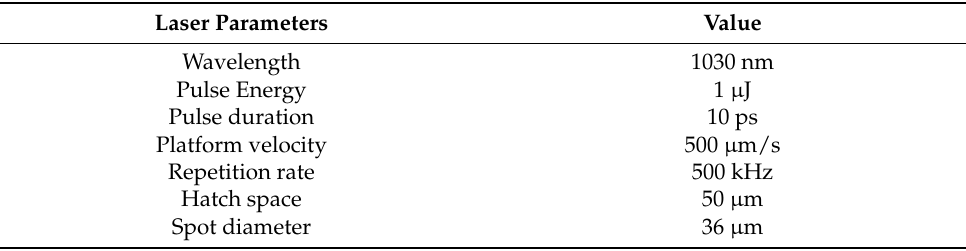
Table 3. A set of optimal parameters used for fabricating single-layer Ti6Al4V samples via picosecond pulse laser.